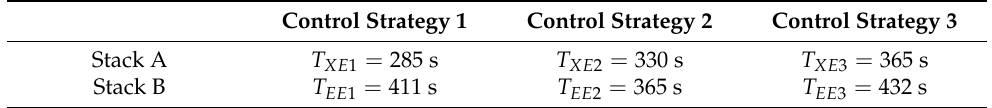
Table 3. T E values of the two stacks under different control